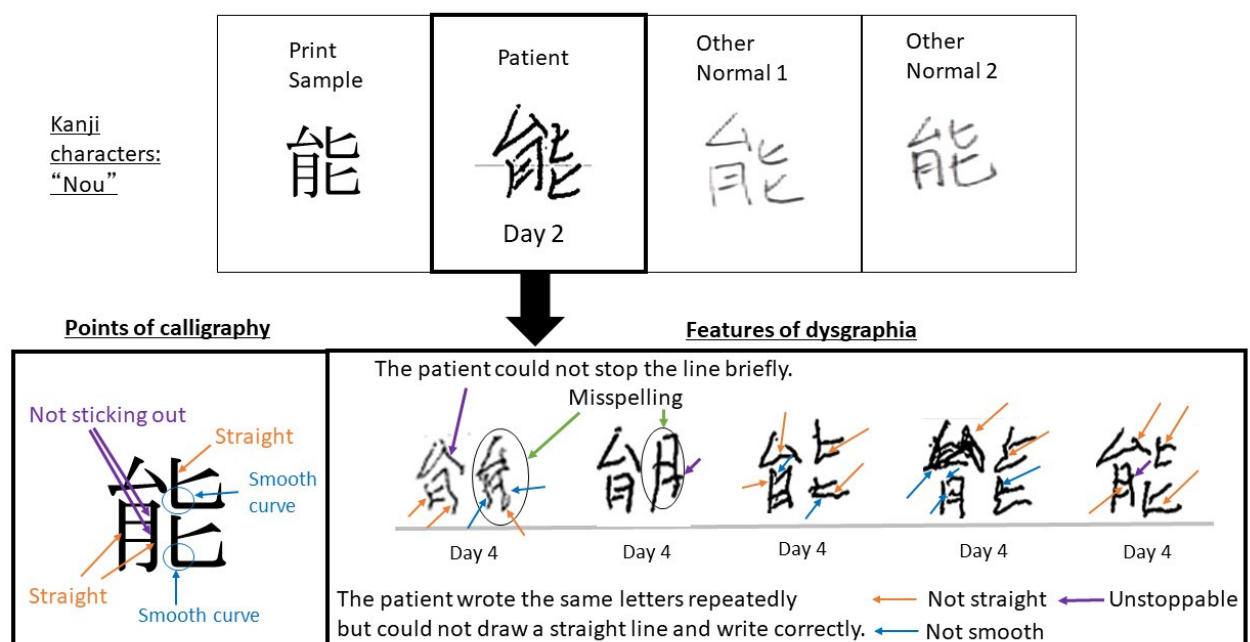
Figure 5. Features of dysgraphia. The patient could not stop the line briefly and draw a straight line. When displaying the abnormality, she could not repeatedly write Kanji characters. Failing to write these familiar Kanji characters is synonymous with failing to write one’s name. Some parts of the Kanji are wrong, which suggests a central nervous system disorder. In addition, the patient may have difficulties with fine motor skills.